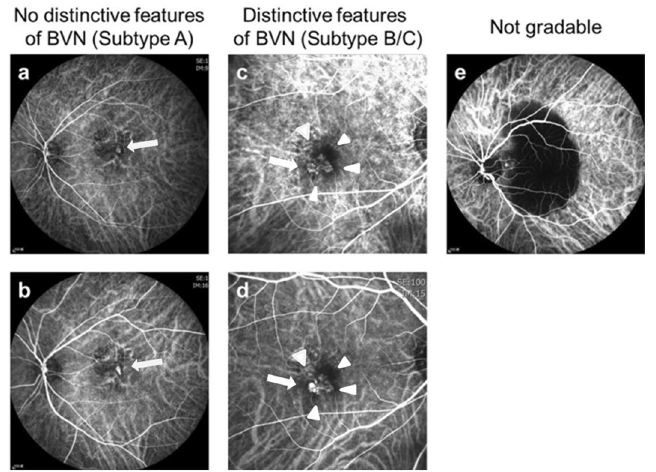
Figure 3. Identification of BVN for the classification of PCV subtypes using ICGA images. ( a , b ) ICGA images without distinct features of a branching vascular network, identified as subtype A. ( a ) Early filling of the dilated vessels (arrow). ( b ) Complete filling of the dilated vessels (arrow). ( c , d ) ICGA images showing branching vascular networks identified as subtype B/C (arrow head). ( c ) Early filling in distinct directions of the branching vascular network (arrow). ( d ) Complete filling of the branching vascular network (arrow). ( e ) An image that was not gradable due to a blockage caused by